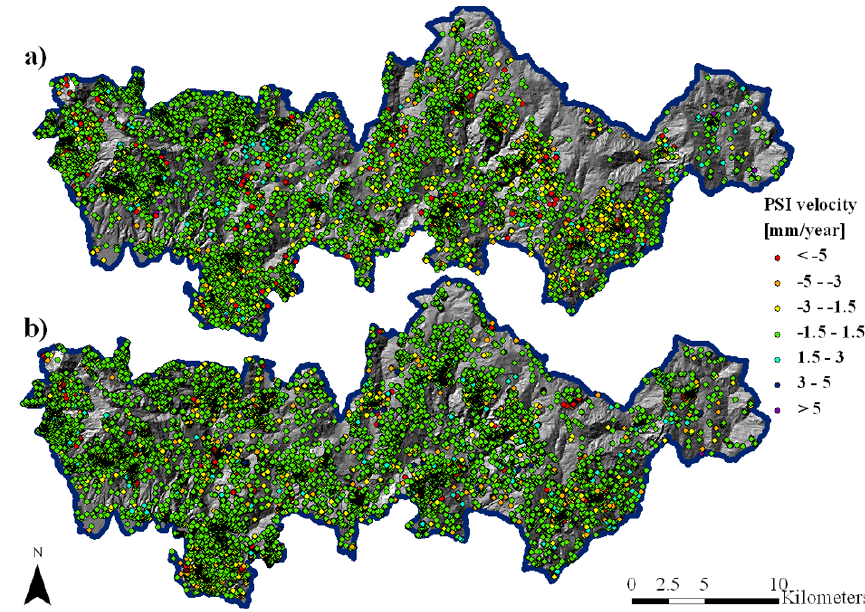
Fig. 4. Distribution of PSI data over the study area according to (a) ERS and (b) ENVISAT sensor.